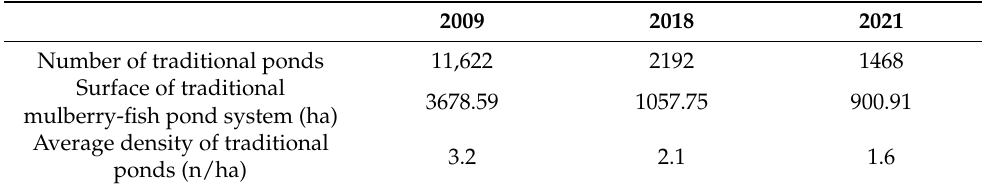
Table 6. Variation in the number and density of traditional fishponds in the period